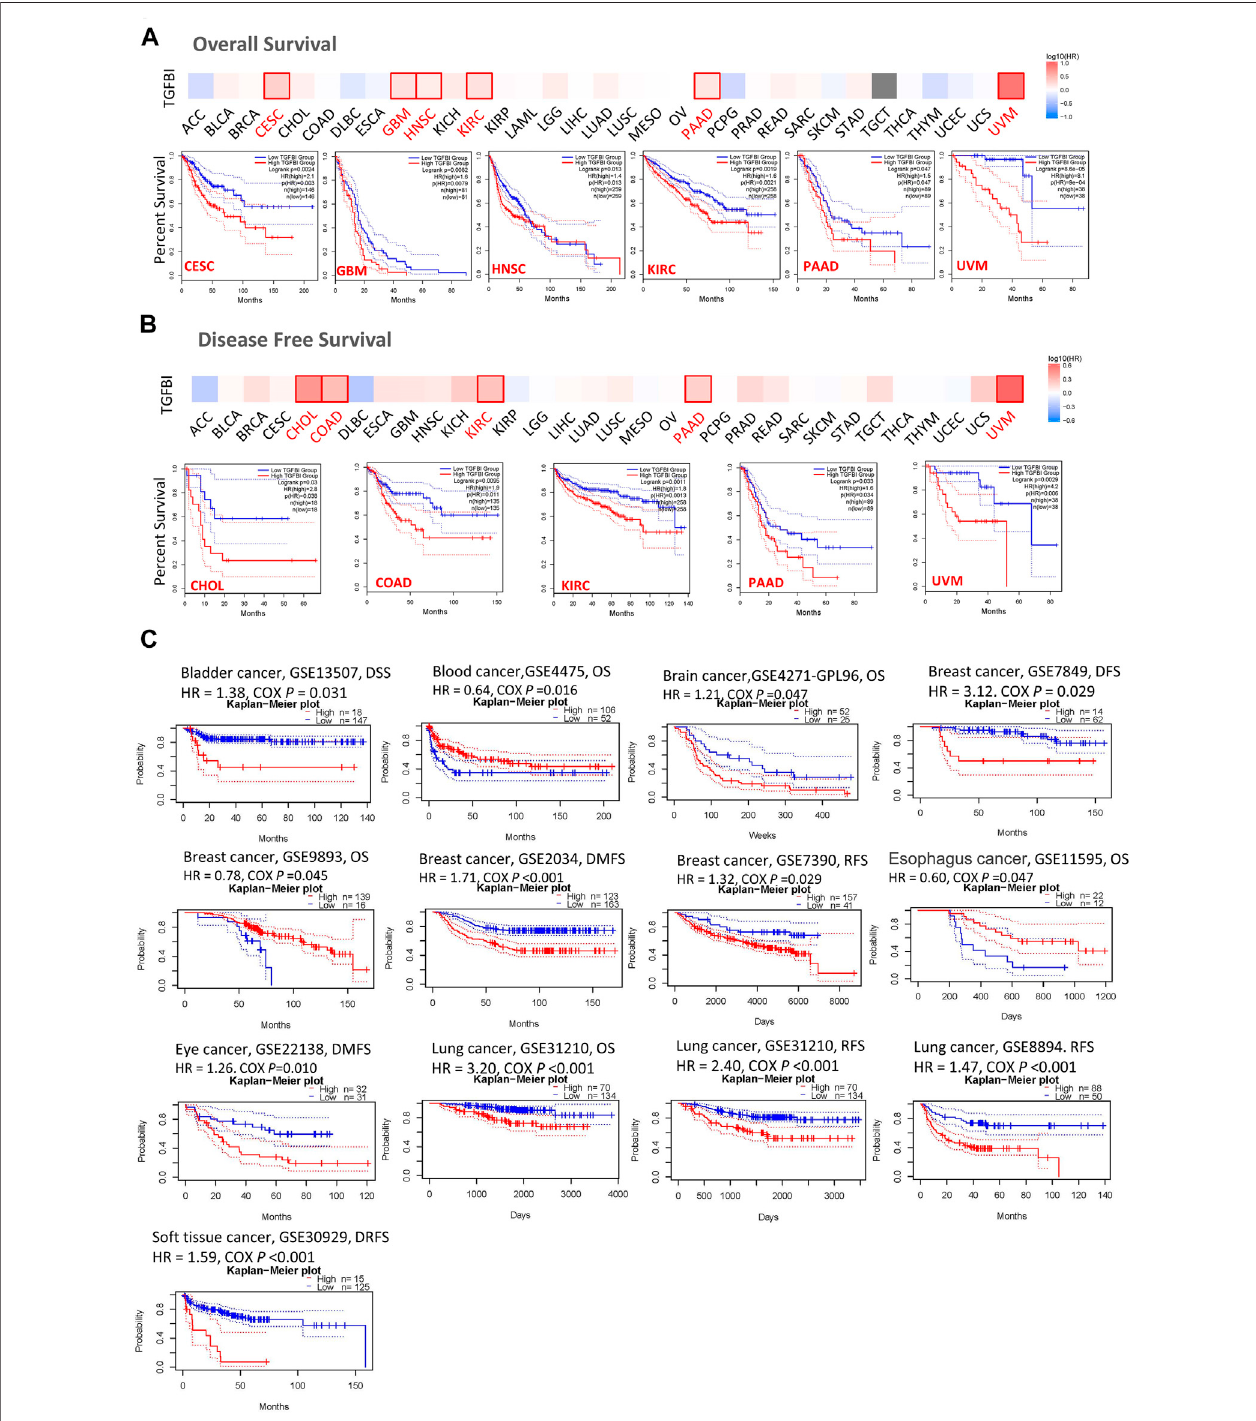
FIGURE3| Associationsof TGFBI expressionwithsurvivalamongcancerpatientsintheTCGAandGEOdatabases. TGFBI expressionand (A) overallsurvivalrate and (B) disease-free survival (DFS)rate invarious tumors in TCGA wereanalyzed using GEPIA2. The Kaplan – Meiersurvivalcurveswithsigni fi cantresults areshown. (C) Kaplan – Meier survival curves of TGFBI expression in 12 GEO cohorts (GSE13507, GSE4475, GSE4271, GSE7849, GSE9893, GSE 2034, GSE7390, GSE11595, GSE22138, GSE31210, GSE8894, and GSE30929), with signi fi cant differences shown. HR represents hazard ratios.